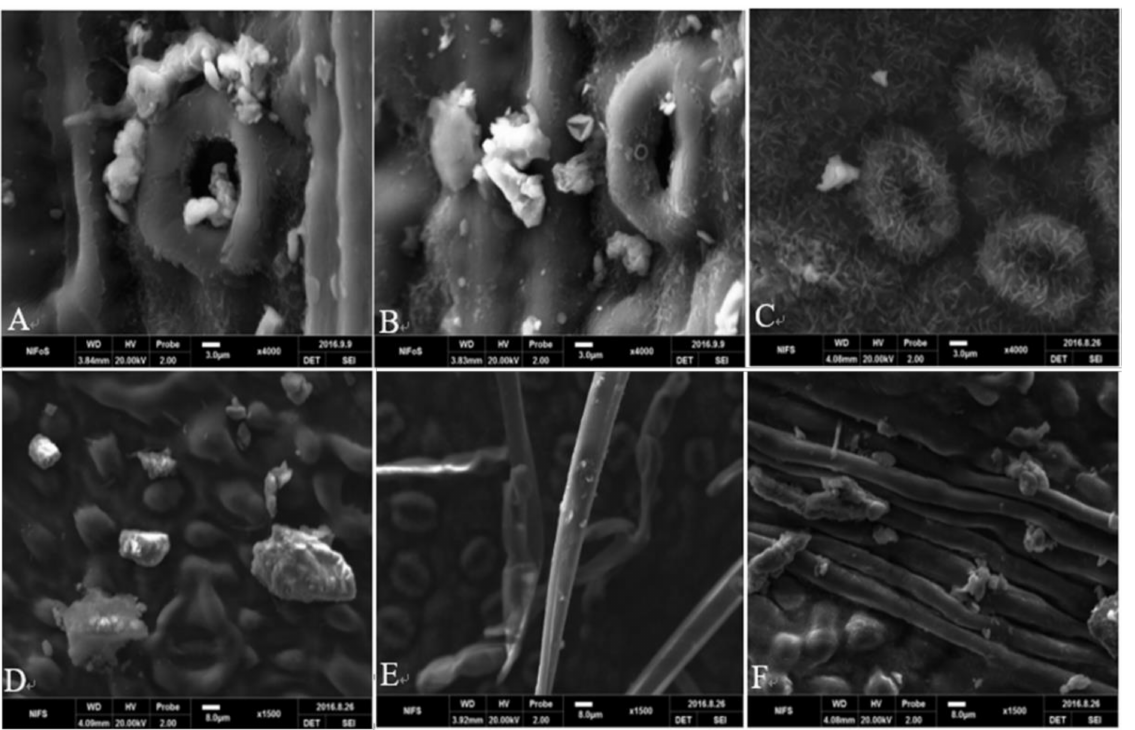
Figure 5. Scanning electron micrographs of particulate matter (PM) adsorbed on leaf surface. All dusty leaves of experimen- tal species were collected, washed with water, filtered, and used for analysis. ( A , B ) PM in and around stomata; ( C , D ) PM in furrowed areas; ( E , F ) PM around